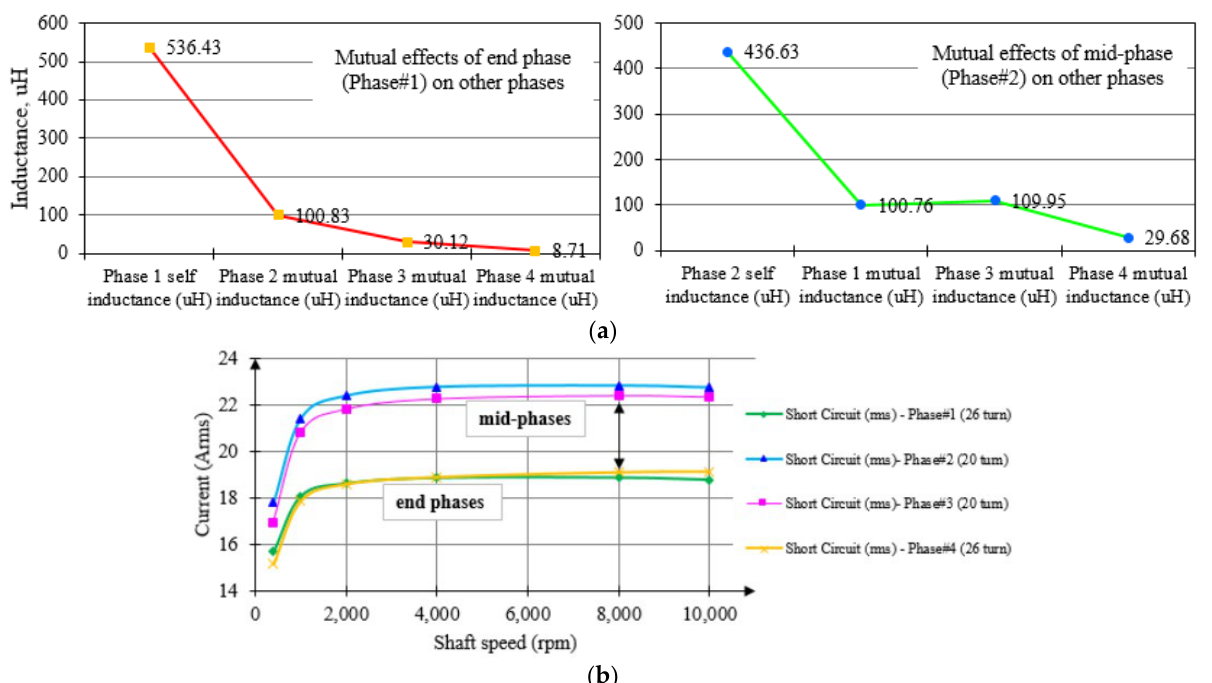
Figure 14. Mutual inductance comparison shown in ( a ), short circuit currents at different shaft speeds given in ( b ).